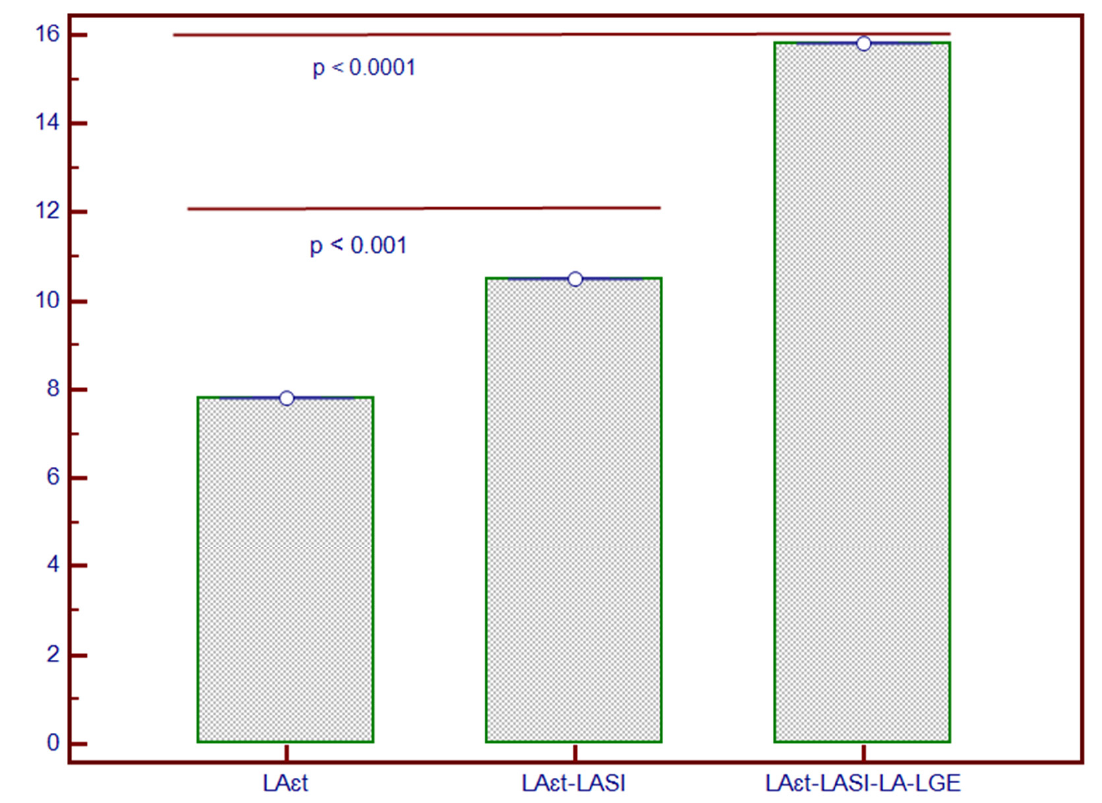
Figure 4. Incremental predictive value of LASI added to LA- ε t and to LA-LGE for composite outcome in patients with NIDCM. * The y-axis represents the Chi-square values of the stepwise Cox proportional-hazard models. Abbreviations: LA- ε t , left atrial total strain; LA-LGE, left atrial late gadolinium enhancement; LASI, left atrial sphericity index; NIDCM, non-ischaemic dilated car- diomyopathy.